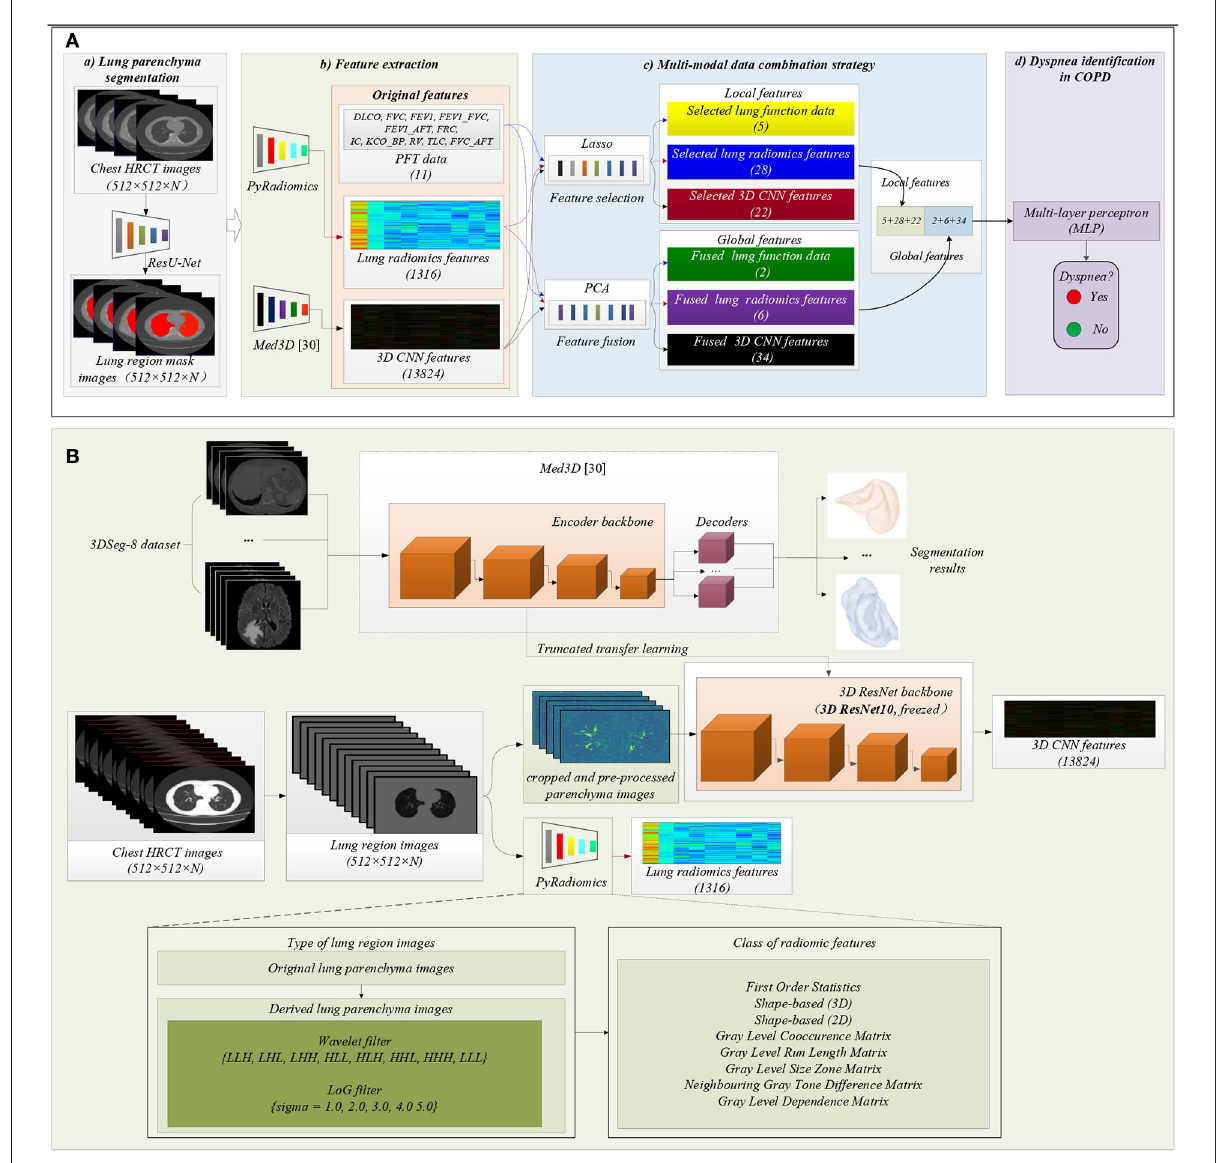
FIGURE2 The framework of the proposed method. (A) The flow chart of the proposed method: (a) Lung region (ROI) segmentation; (b) Features extraction; (c) Multi-modal data combination strategy; (d) Dyspnea identification in COPD based on MLP classifier; (B) Detailed process of features extraction, including lung radiomics features and 3D CNN